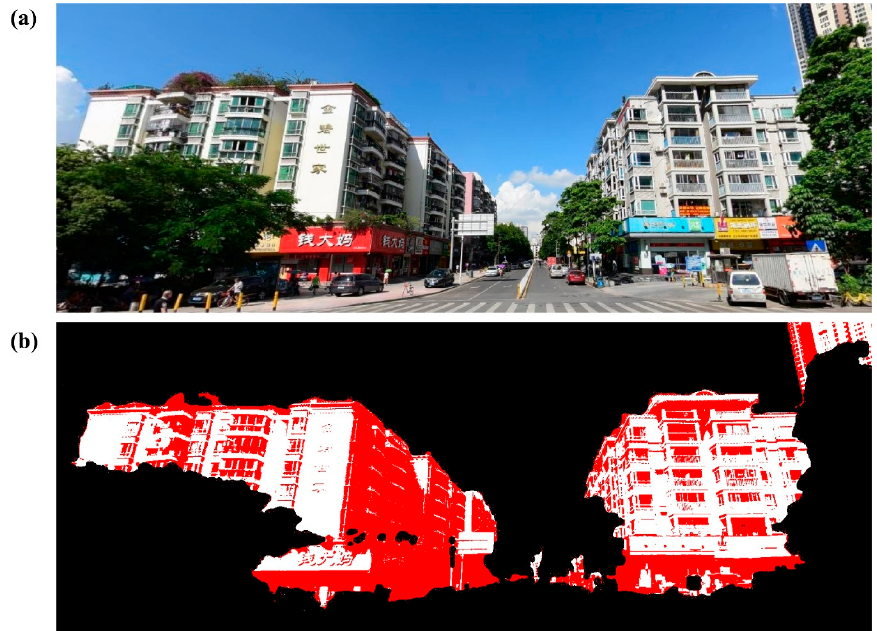
Figure 5. An illustration of shadow detection from a street-view image. ( a ) An example of BSV panorama with shadow, ( b ) the shadow detection result on the extracted urban façade image. The error of the results of dominant color evaluation increase when the proportion of shadow areas is changed. At present, to eliminate the effect of the shadow area on the extraction of DCUF from street-view images, we chose to delete pixels of the building